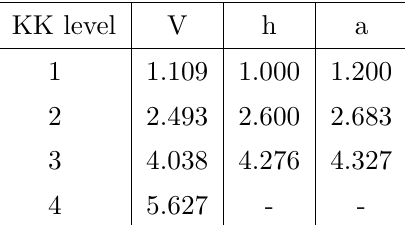
- for the BM1 point 1